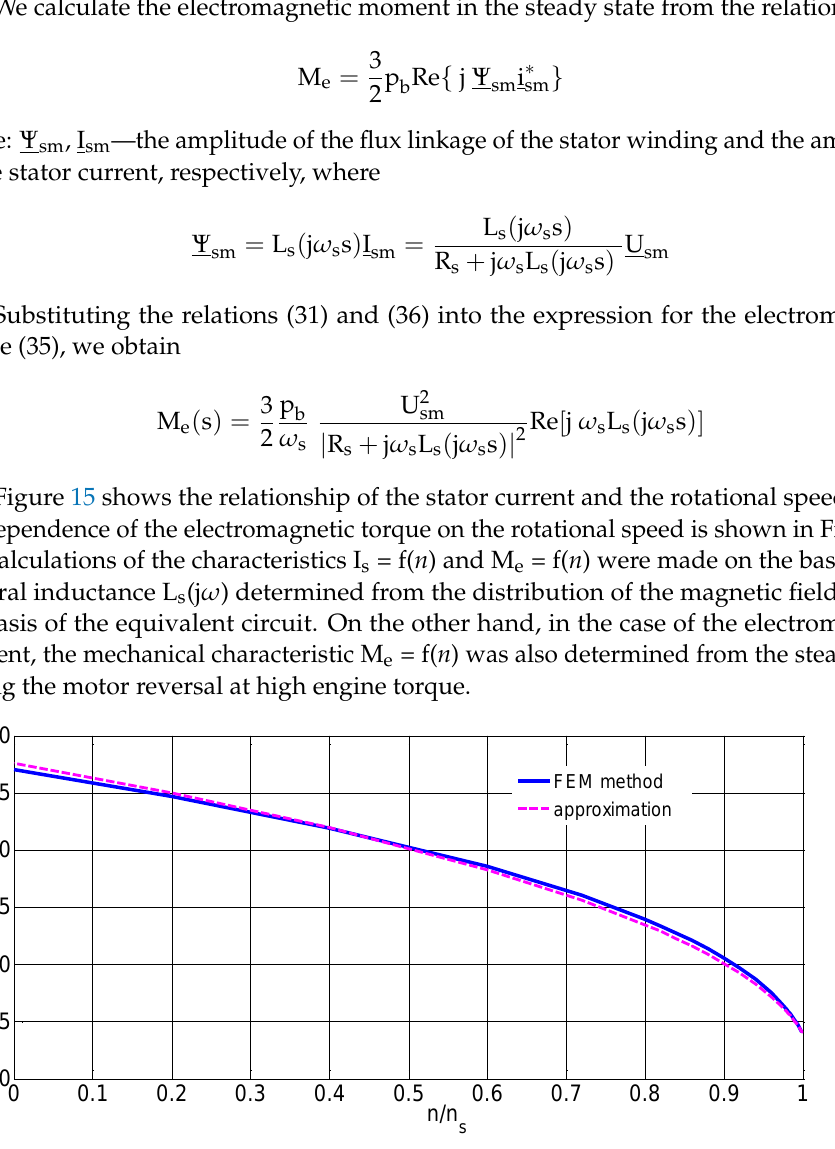
Figure 14. Relationship of resistance and reactance of a solid rotor and of frequency; full lines — resistance, dashed lines — reactance.